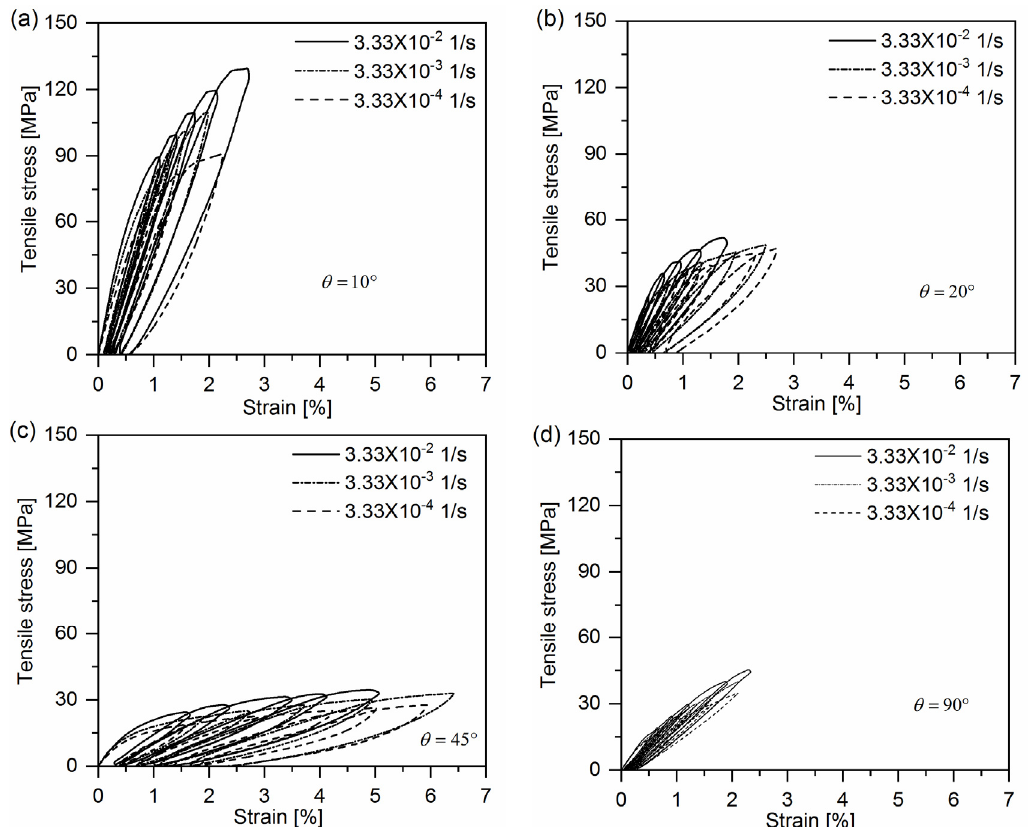
Figure 5. Representative cyclic loading ‐ unloading curves for quasi ‐ UD E ‐ glass/polypropylene composite under different strain rates: ( a ) θ = 10°; ( b ) θ = 20°; ( c ) θ = 45° and ( d ) θ = 90°.